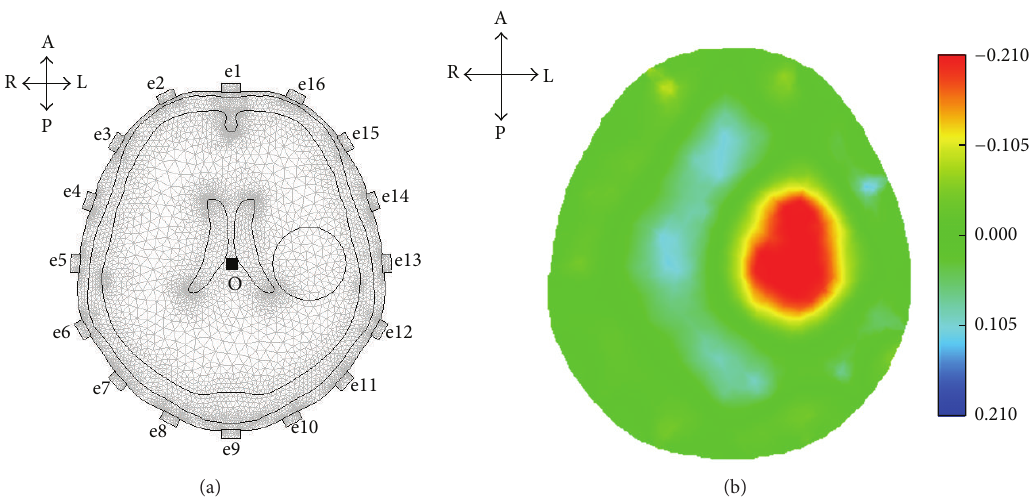
Figure 6: SEIT imaging based on simulated EIT data. (a) A simulated stroke lesion was set on the left side of the model. (b) The reconstructed SEIT image reflected the simulated lesion (A: anterior; P: posterior; L: left; and R: right).